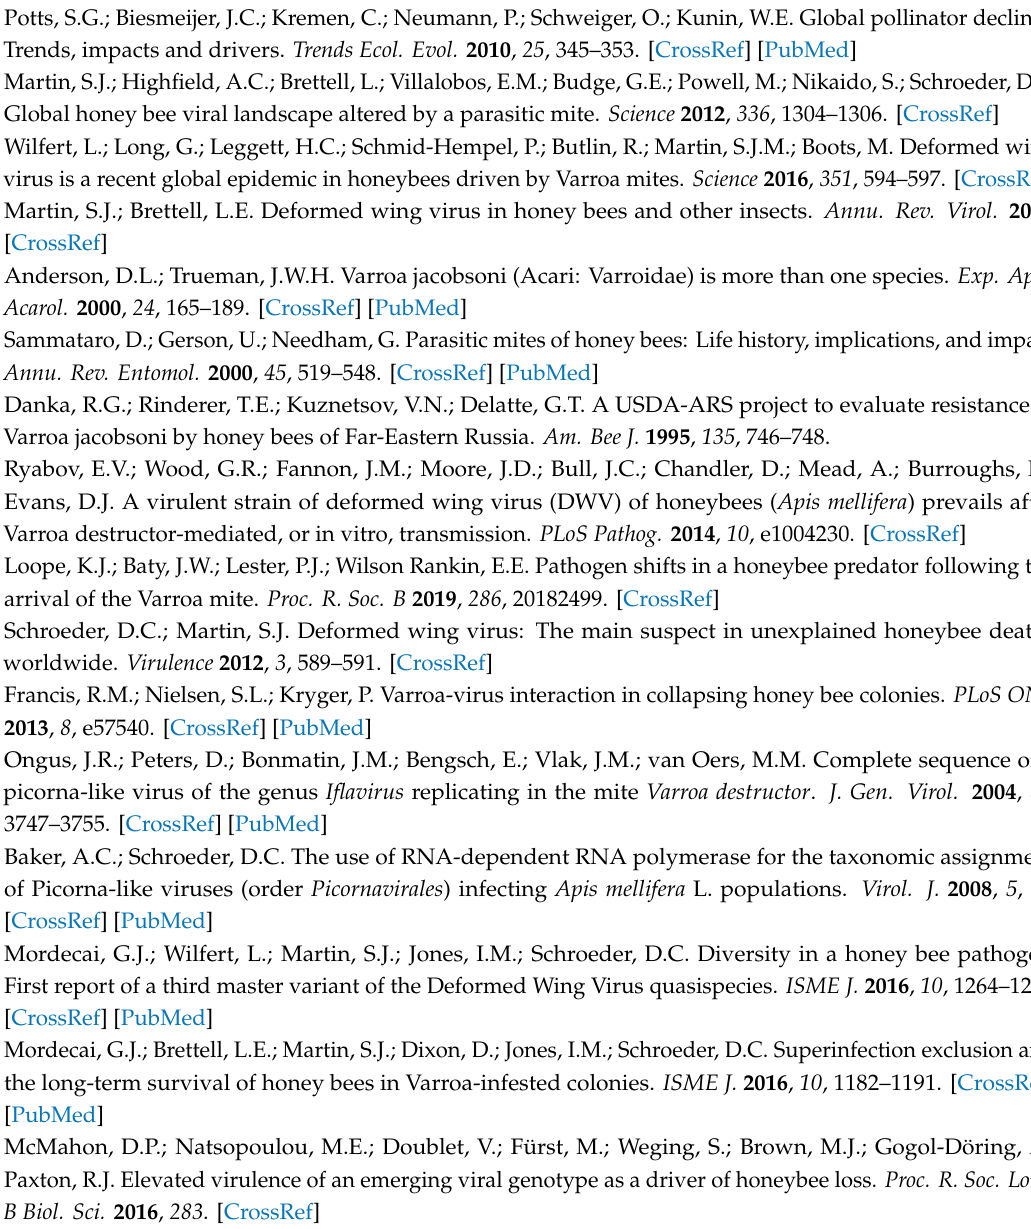
Table S1: The DWV master variants and total viral load in colonies that survived or died. Samples were collected in late summer, 2016, from England and Wales. BL = below the quantifiable limit of detection. Author Contributions: J.L.K., D.C.S., and S.J.M. conceived and designed the experiments; R.O. organized and provided the U.S. samples; J.L.K., F.S.d.S., and C.S. performed the experiments; J.L.K. analyzed the